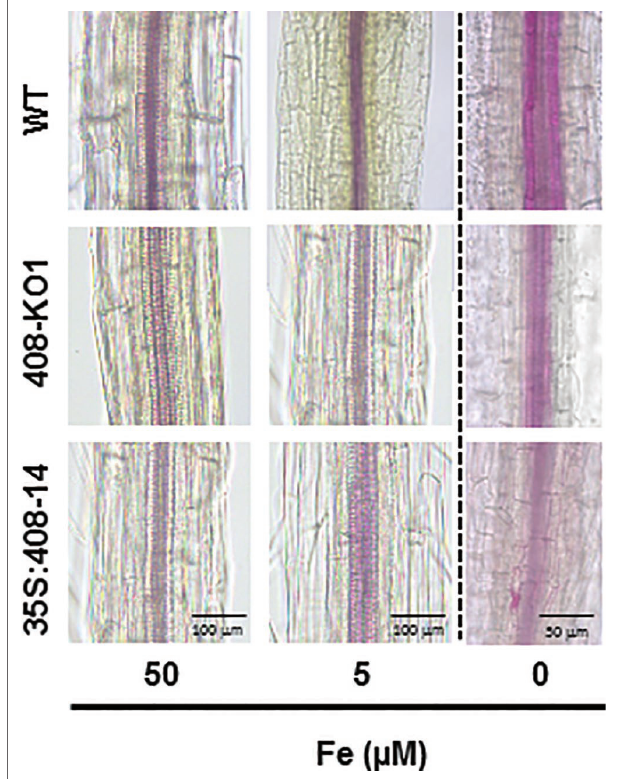
FIGURE 2 | Lignin staining under iron deficiency conditions of the altered miR408 expression seedlings. Photographs of the representative lignin stained stems from the 20-day-old seedlings from the wild-type (WT), 408-KO1, and 35S:408-14 lines grown on 1/2 MS plates containing 50, 5, and 0 μ M Fe citrate, pH 5.6. Stems ( n ≥ 10 for each genotype) were stained with phloroglucinol saturated with HCl and photographed under a microscope. The length of the bars indicates 100 μ m in 50 and 5 μ M Fe citrate conditions and 50 μ m in 0 μ M Fe